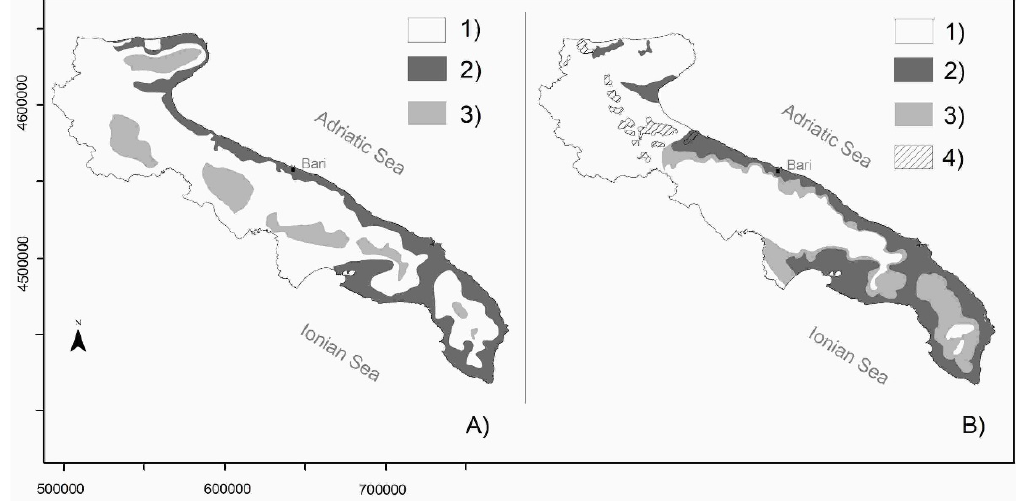
Figure 8. Groundwater quality zonation for regulation (after [27]). ( A ) As regulated in 1984 (PRA or PLAN1, no more applicable from 2009): (1) zone without discharge restrictions; (2) low-quality